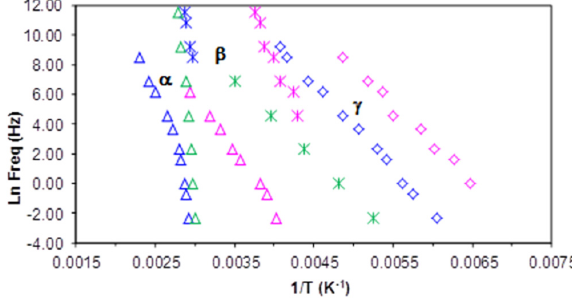
Figure 16. Relaxation map for PEI2000-PLA5 (blue), PEI2000 (pink), and PLA (green) at 2 °C/min: α -relaxation (triangles), β -relaxation (asterisks), γ -relaxation (rhombus).